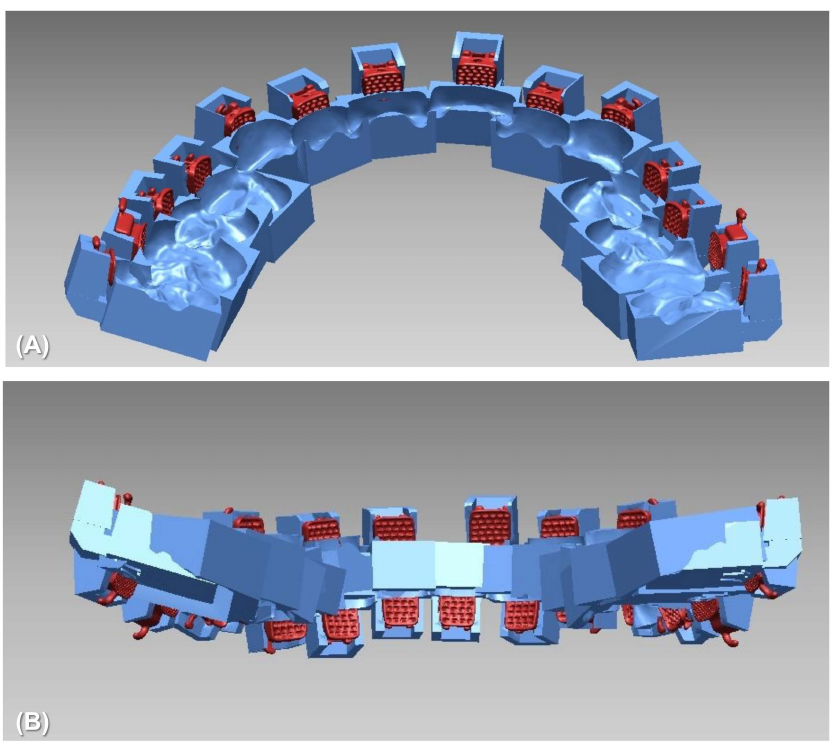
Figure 2. Examples of one-body jig system. ( A ) For maxillary dentition, ( B ) For whole